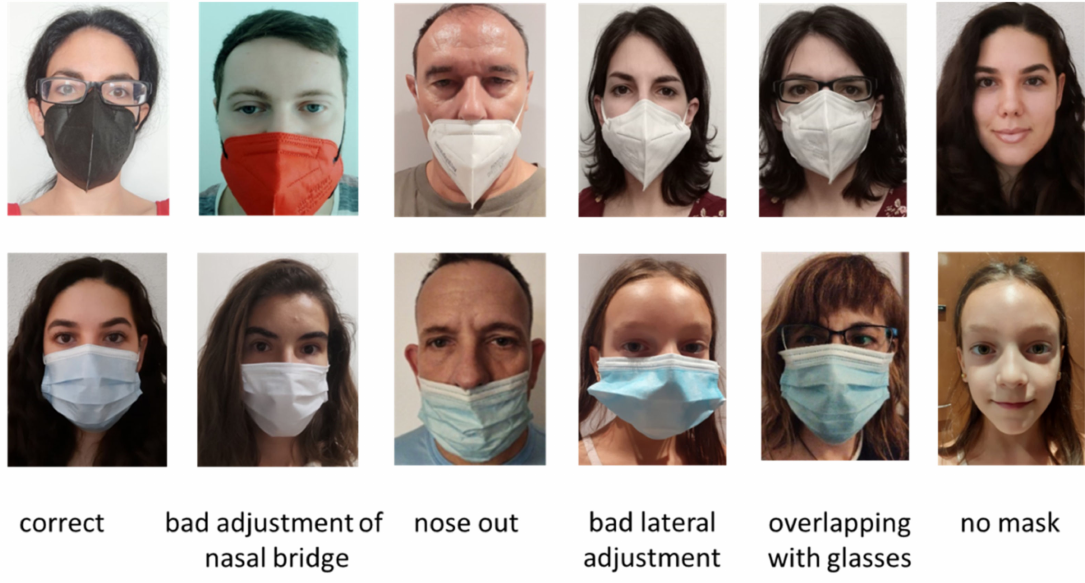
Figure 3. Example of samples of the 6 categories detected once